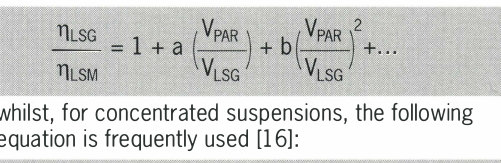
Fig. 2: Experimental set-up for recording dissolving